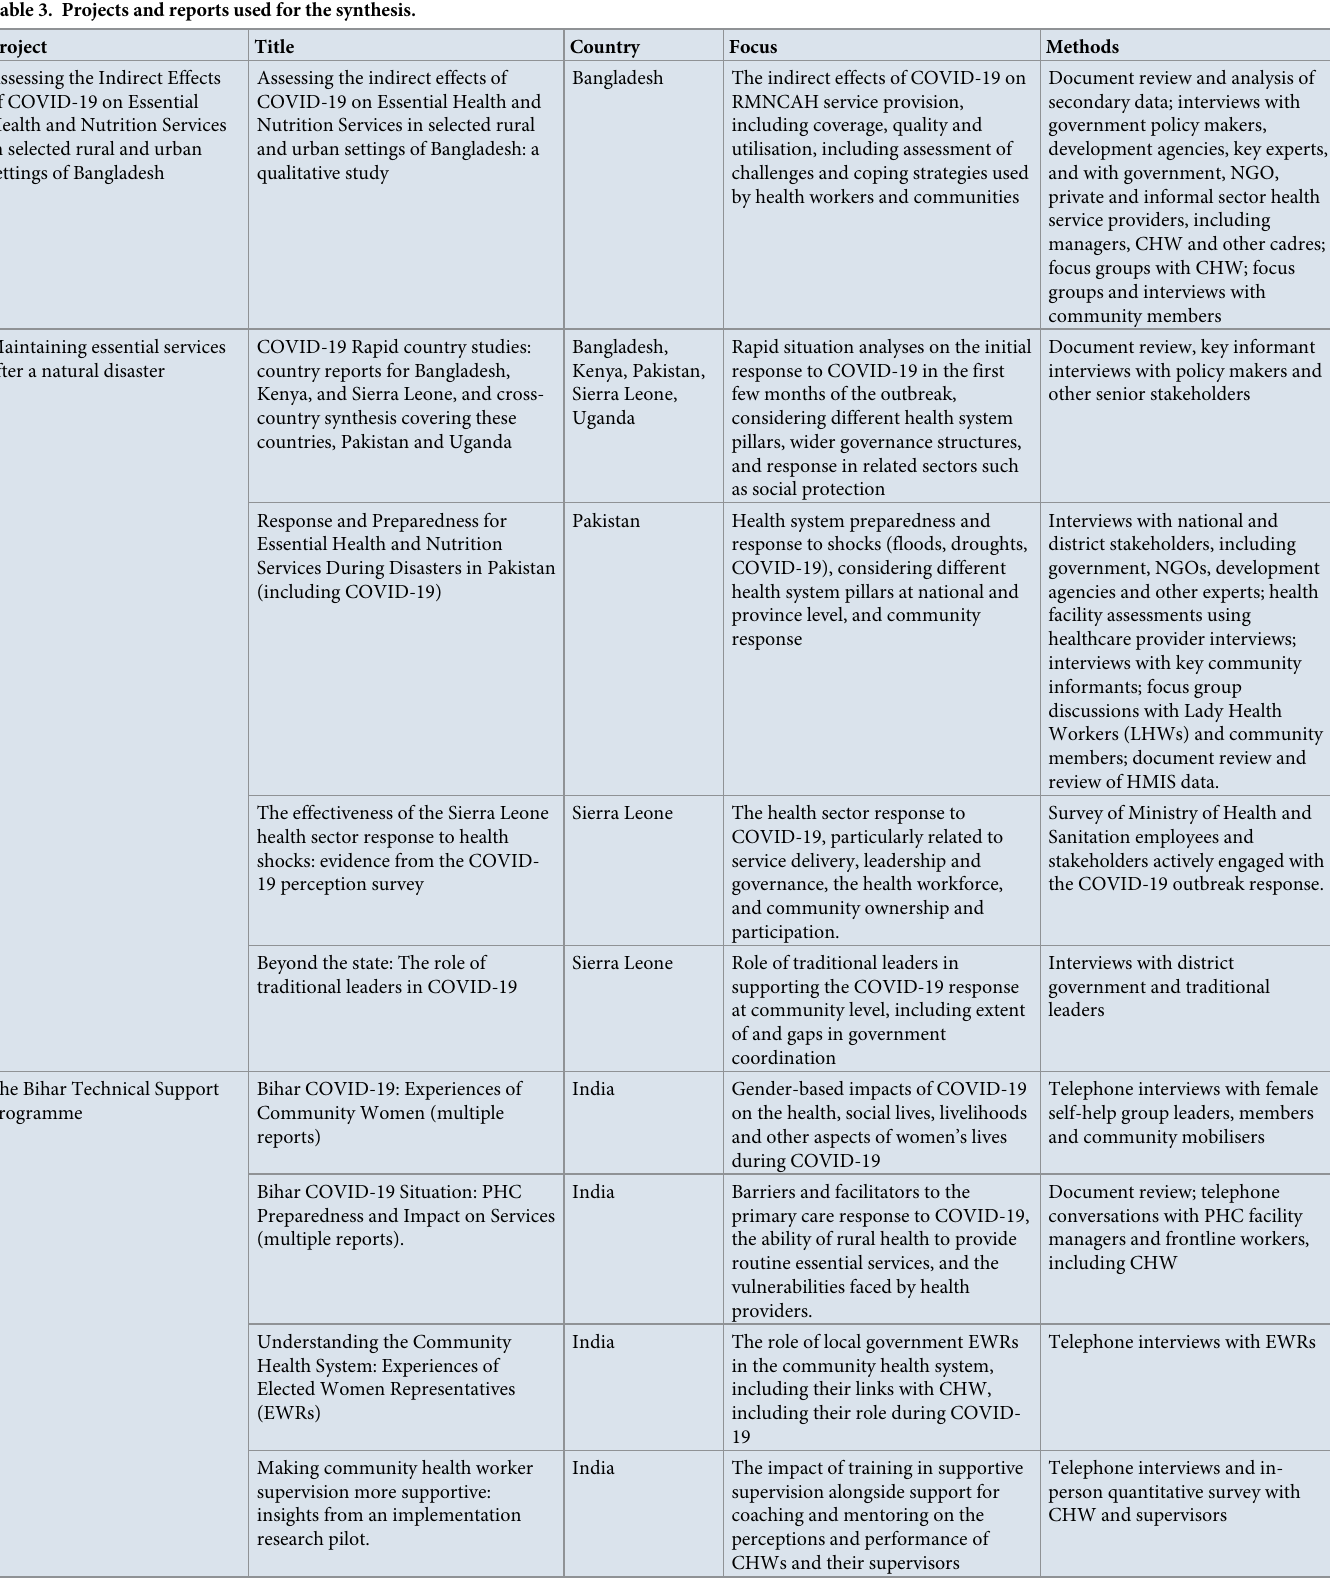
Table 3. Projects and reports used for the